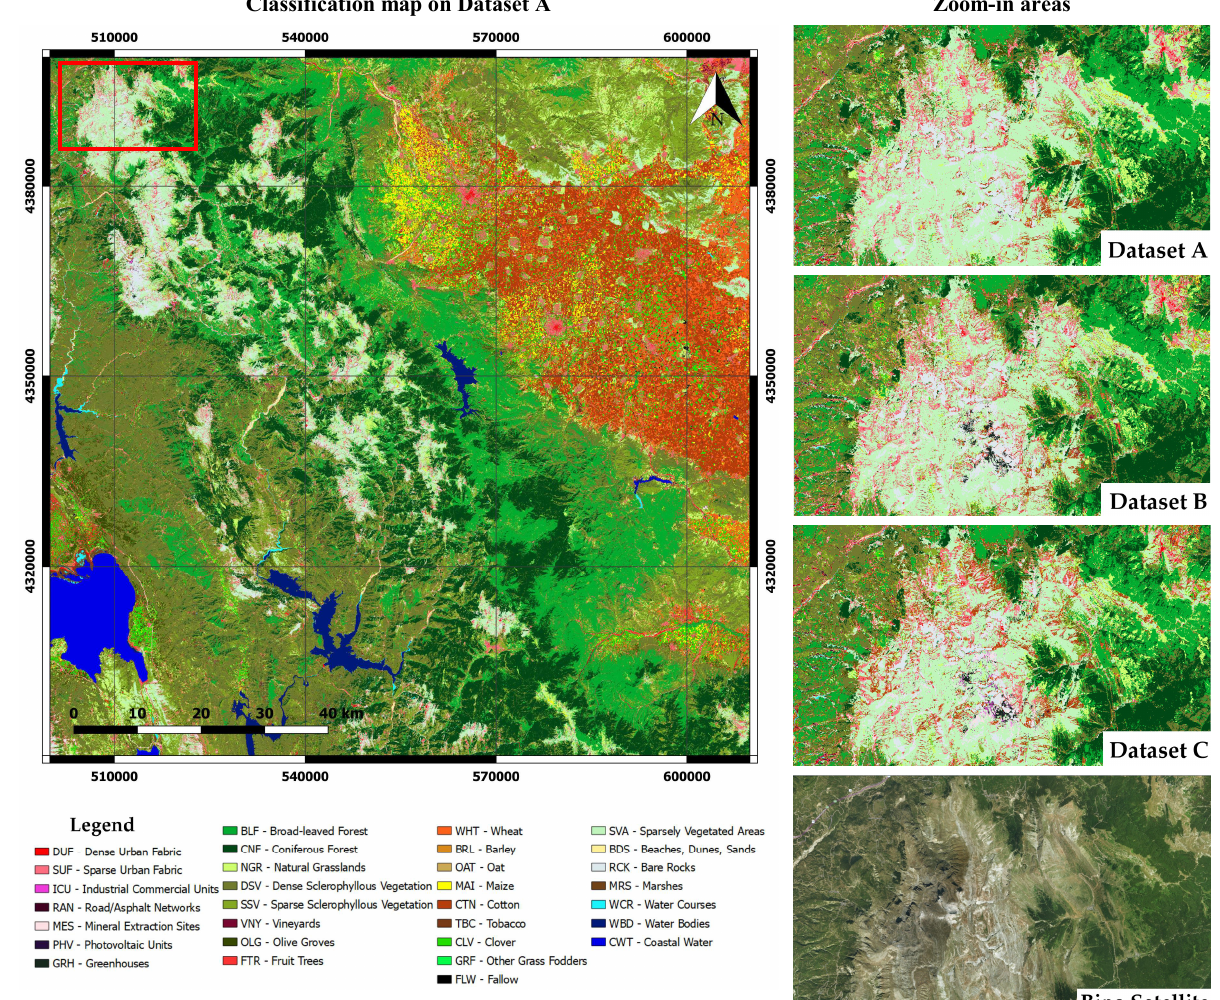
Figure 3. Classification map of the study area from experiment on Dataset A (left) and zoom-in region of mount Lakmos from the maps of all three datasets along with Bing Satellite imagery of the same region